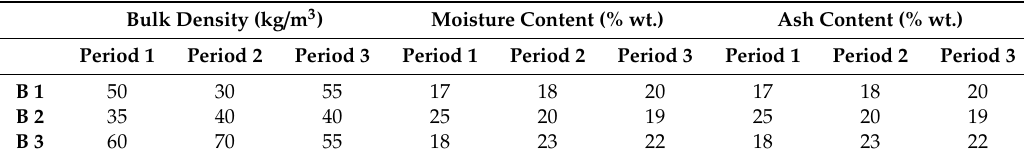
Table 3. Biomass Quality Parameters.